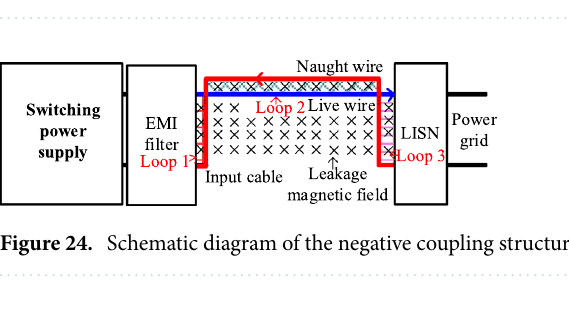
Figure 23. Schematic diagram of the projection of the proposed plug loop structure.